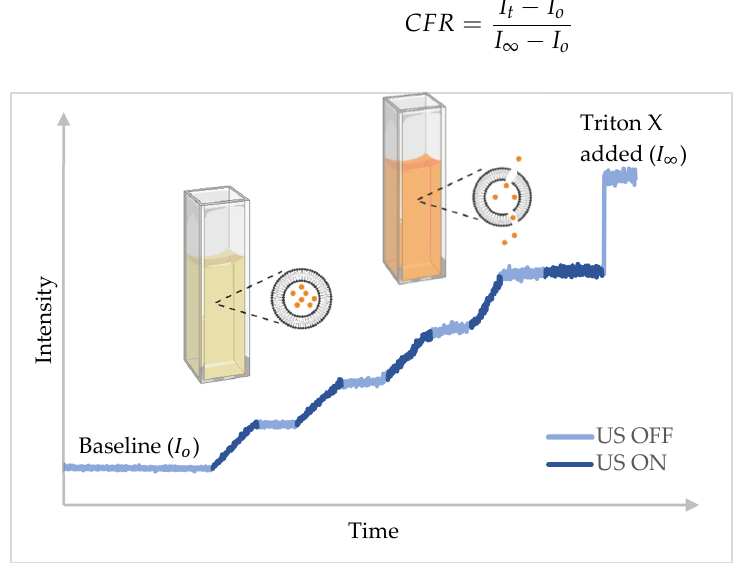
Figure 4. Calcein release from calcein-loaded liposomes using pulsed LFUS.